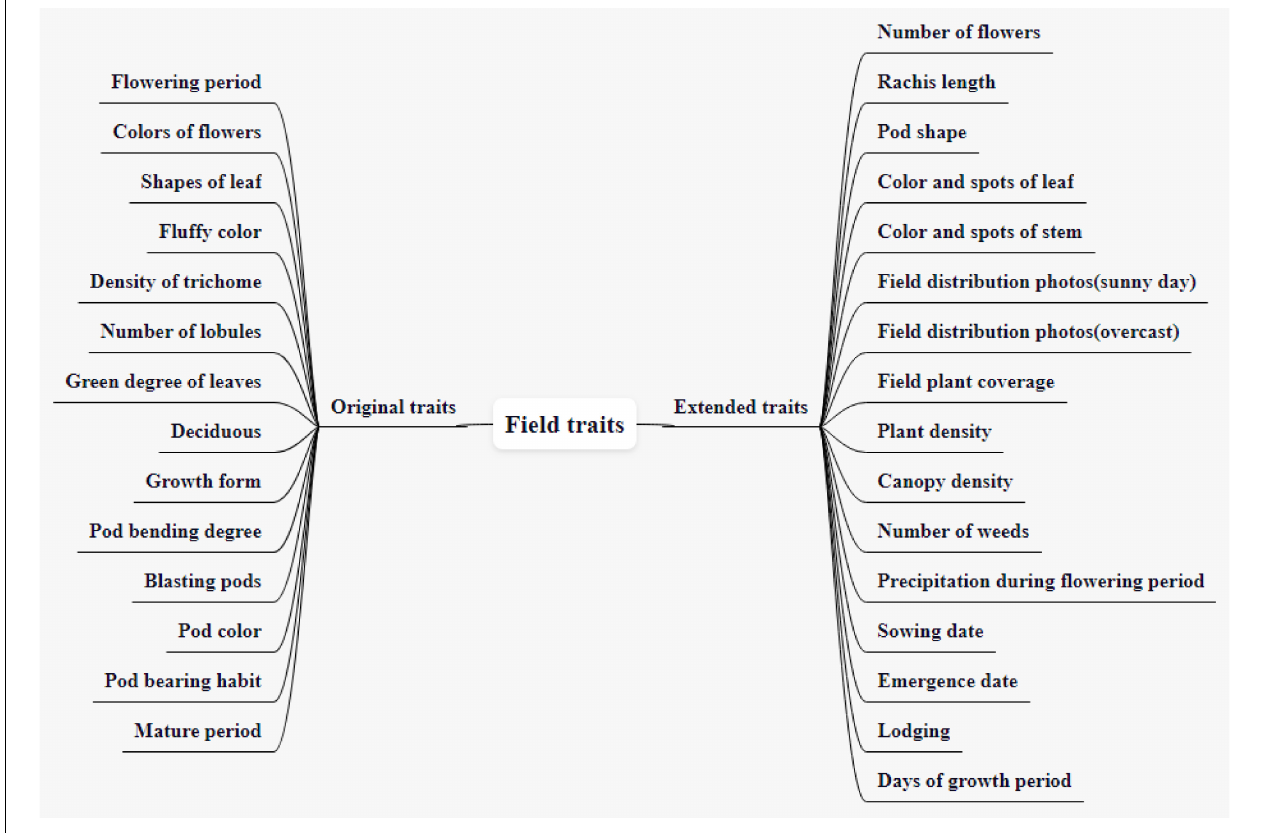
FIGURE 1 | Field plant traits and the